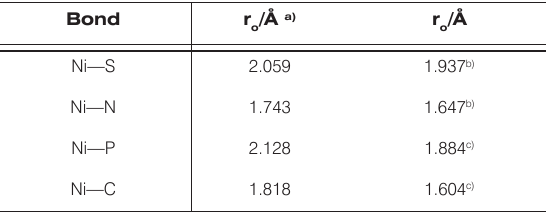
Table 4. Values of r